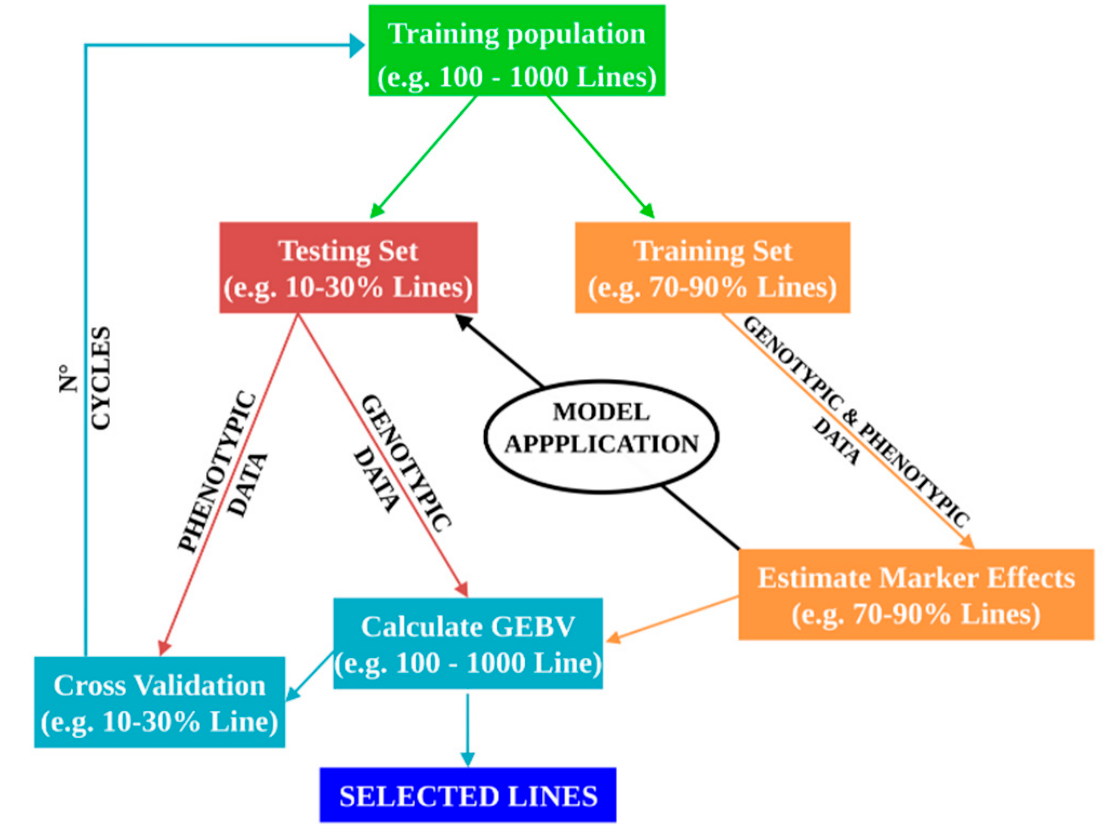
Figure 1. Flowchart of a genomic selection (GS) breeding program. GS overview with cross-validation using a training set (70–90% out of 100–1000 lines) to estimate marker e ff ects in order to obtain a genomic estimated breeding value (GEBV) of lines in the testing set (10–30% out of 100–1000 lines). Finally, phenotypic and genotypic data of the training set are used to set up the prediction